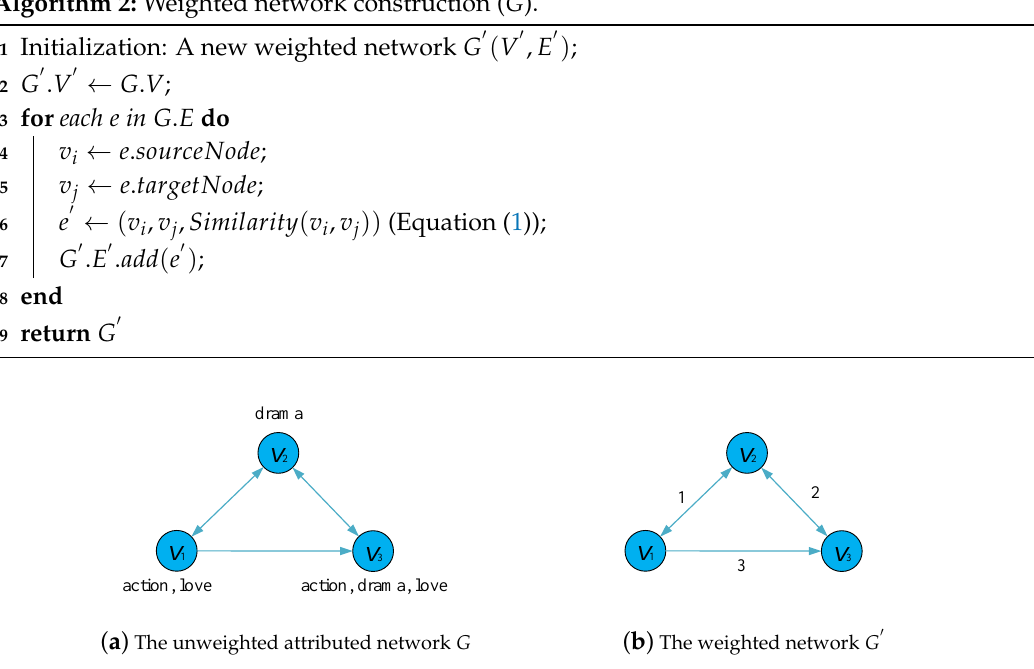
Figure 3. An example of the reconstruction of the weighted network G (cid:48) from the unweighted attributed network G based on the node similarity. Texts next to nodes represent their node